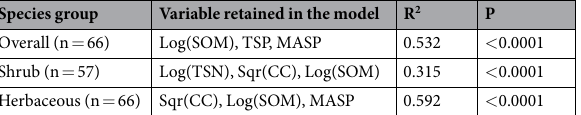
Table 4. Variables retained in the regression models for explaining LPSR for overall, shrub and herbaceous species. TSN, total nitrogen; TSP, total phosphorus; SOM, soil organic matter; CC, clay content; MASP, mean annual summer precipitation.